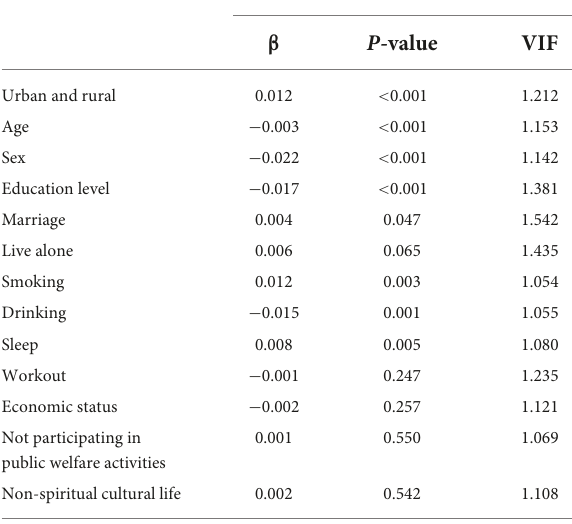
TABLE 2 Correlative factors’ effect on cardiac-cerebral vascular disease based on multiple linear regression